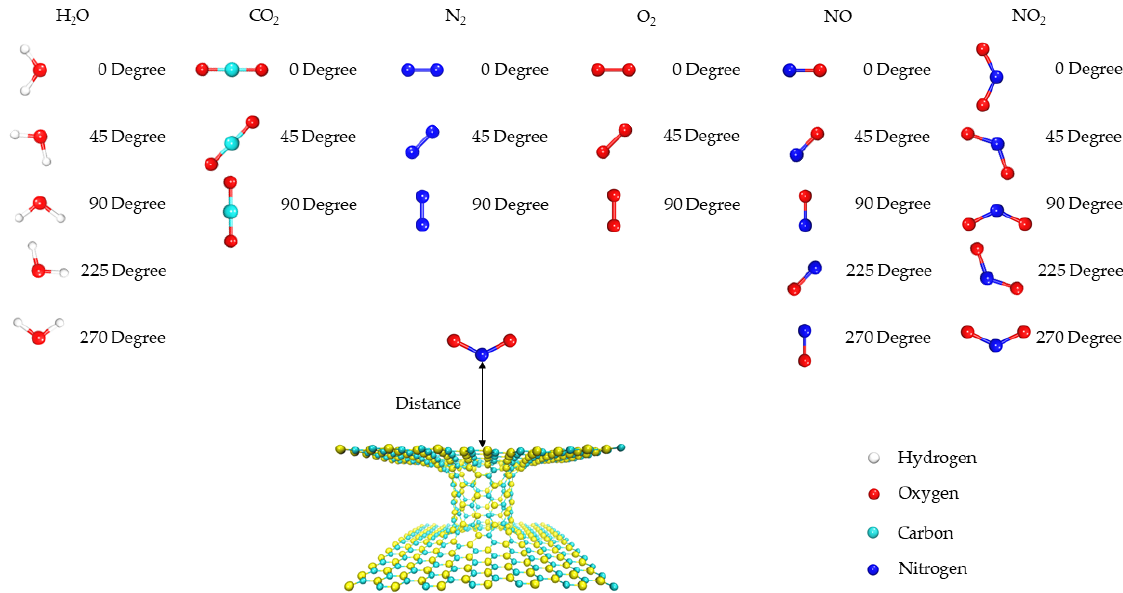
Figure 2. Models for the diffusion of gas molecules with various orientations into the 3D pillared SiC nanostructure.